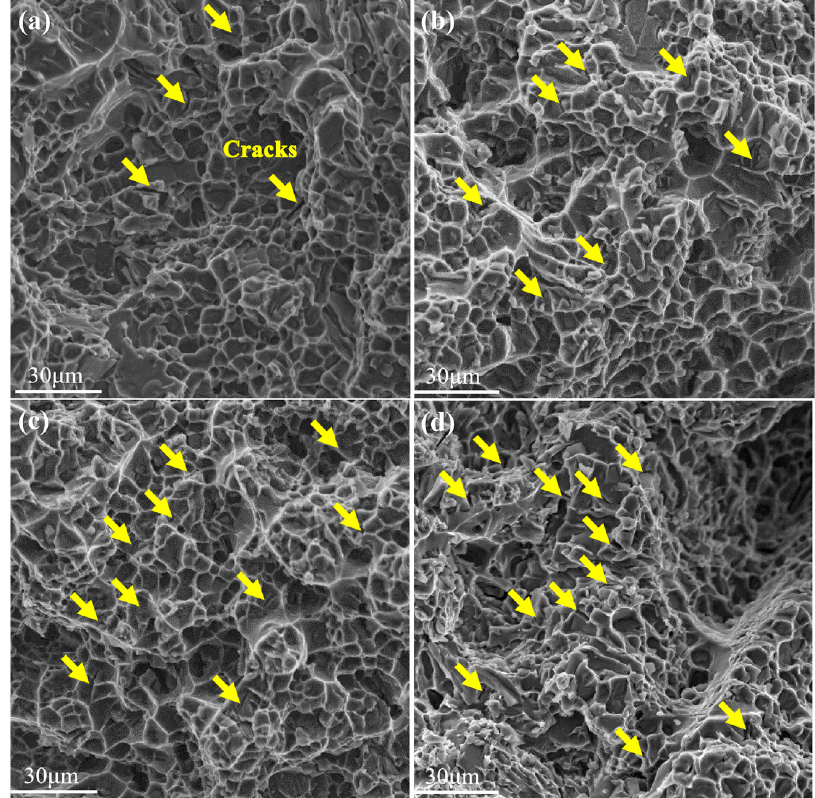
Figure 14. Fracture surfaces of the alloys after T6 treatment: ( a ) A1, ( b ) A2, ( c ) A3, ( d ) A4.